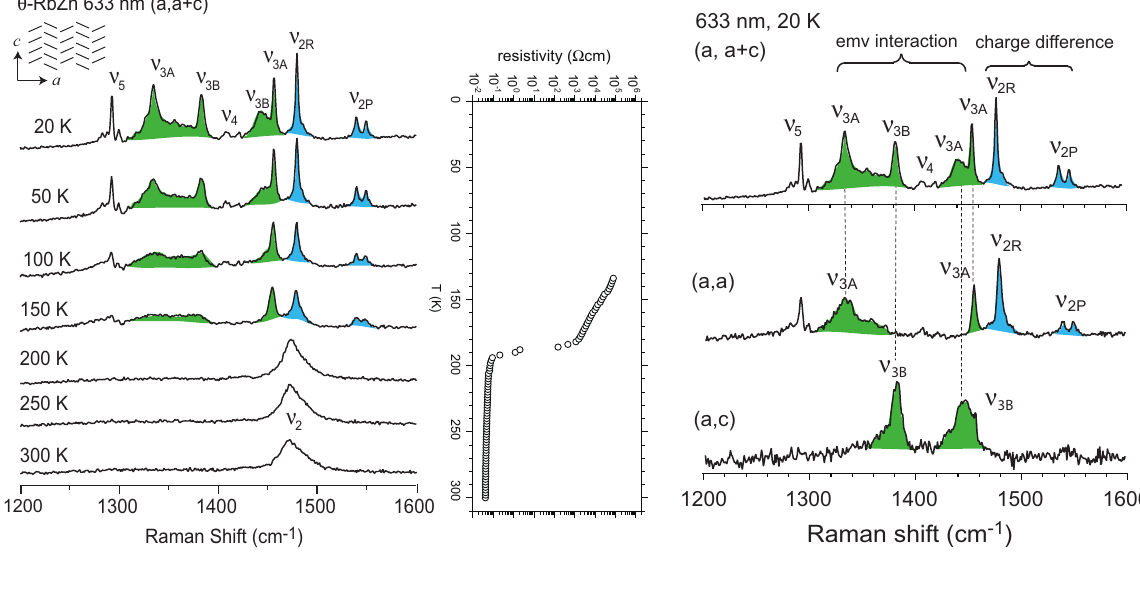
Figure 10. ( left panel ) Temperature dependence of the Raman spectrum and the electrical RbZn(SCN) . The ν and ν modes are shown by blue and resistivity of θ -(BEDT-TTF) 2 4 2 3 green colors. The inset shows the herringbone arrangement of BEDT-TTF with respect to the crystallographic axes; ( right panel ) Polarized Raman spectrum of θ -RbZn measured at modes (green) in the top panel are classified into two groups by 20 K. The four ν 3 polarization. The Raman spectra are modified from Figures 14,15 of ref.